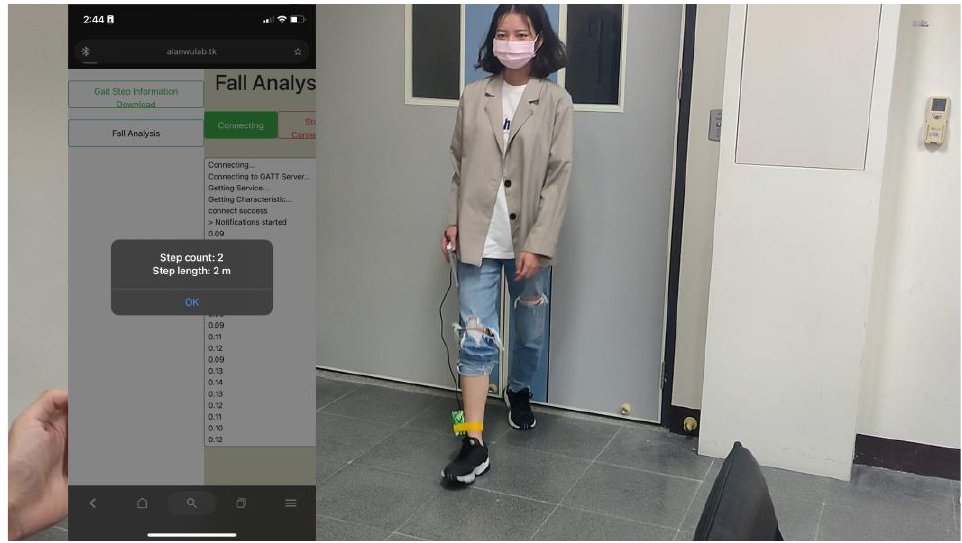
Figure 9. Step length detection of CPGAFDWD in iOS.